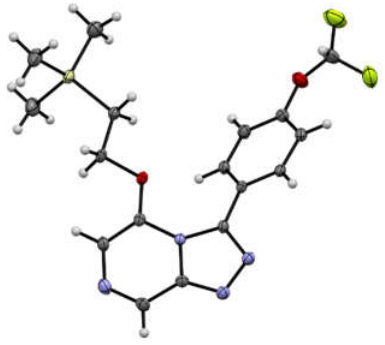
Figure 4. ORTEP drawing of compound 5 .